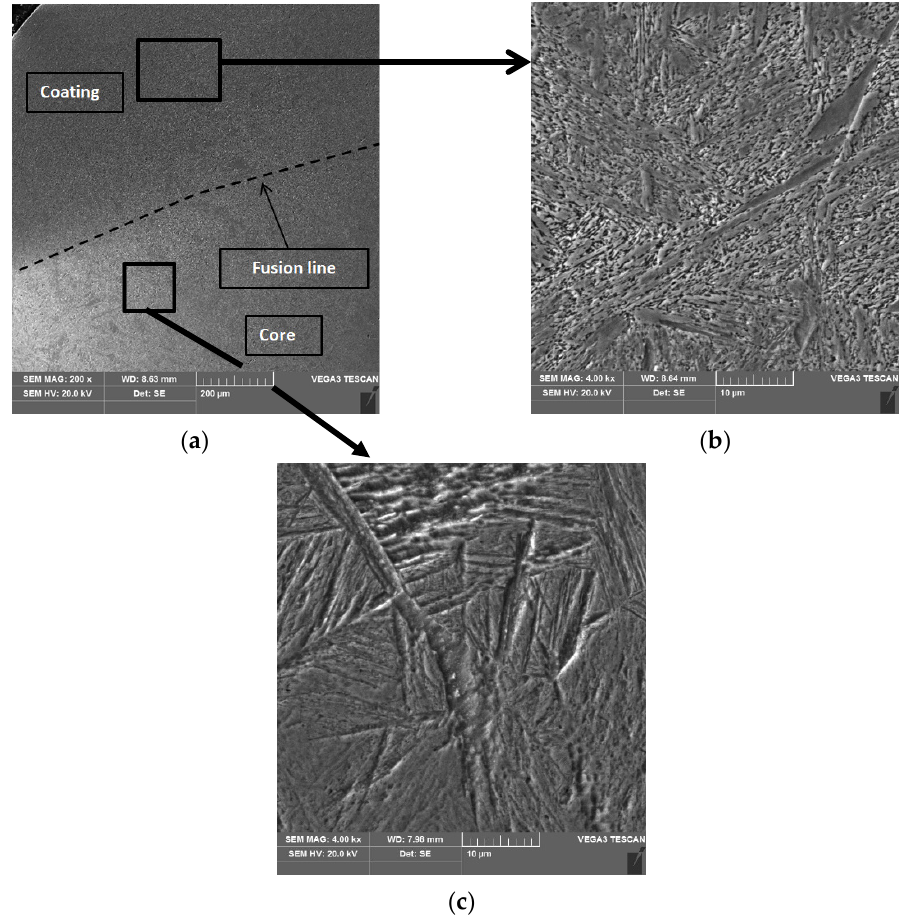
Figure 12. Microstructure of a turbocharger shaft journal cross-section after double-layer hardfacing. Transition zone microstructure, coating-core ( a ), coating microstructure ( b ), core microstructure ( c ).